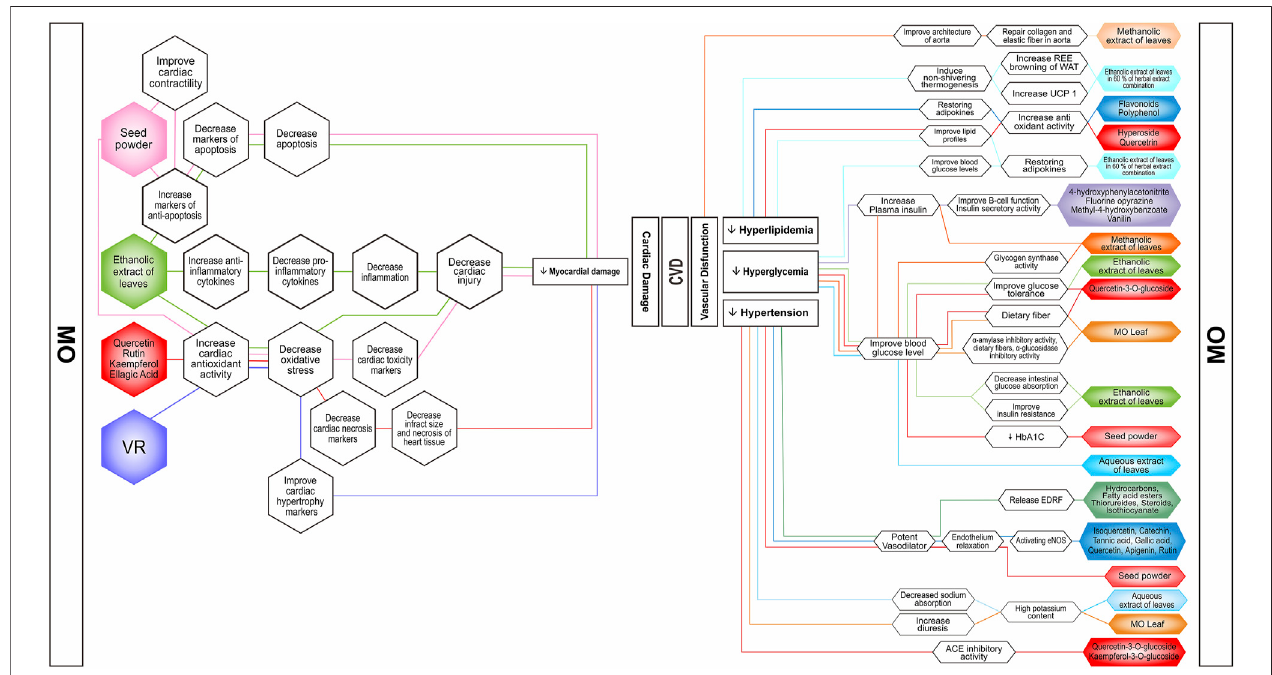
FIGURE 1 | Possible mechanism of actions of Moringa oleifera nutrients and bioactive compounds in combating vascular dysfunctions and myocardial damages. Thebioactive compoundspreventandimproveCVDs ’ riskfactors suchashyperlipidemia,hyperglycemia,and hypertension. MOpreparationsareintheformofisolated metabolites,wholeextracts,orpureparts.NoticethatthereisonepromisingapproachtoimproveCVDriskbyinducingnon-shiveringthermogenesis.ACE,angiotensin- converting enzyme; EDRF, endothelium-derived relaxing factor; eNOS, endothelial nitric oxide synthase; HbA1C, hemoglobin A1C; REE, resting energy expenditure; UCP1, uncoupling protein 1; VR, N, α -L-Rhamnopyranosyl vincosamide; WAT, white adipose tissue.